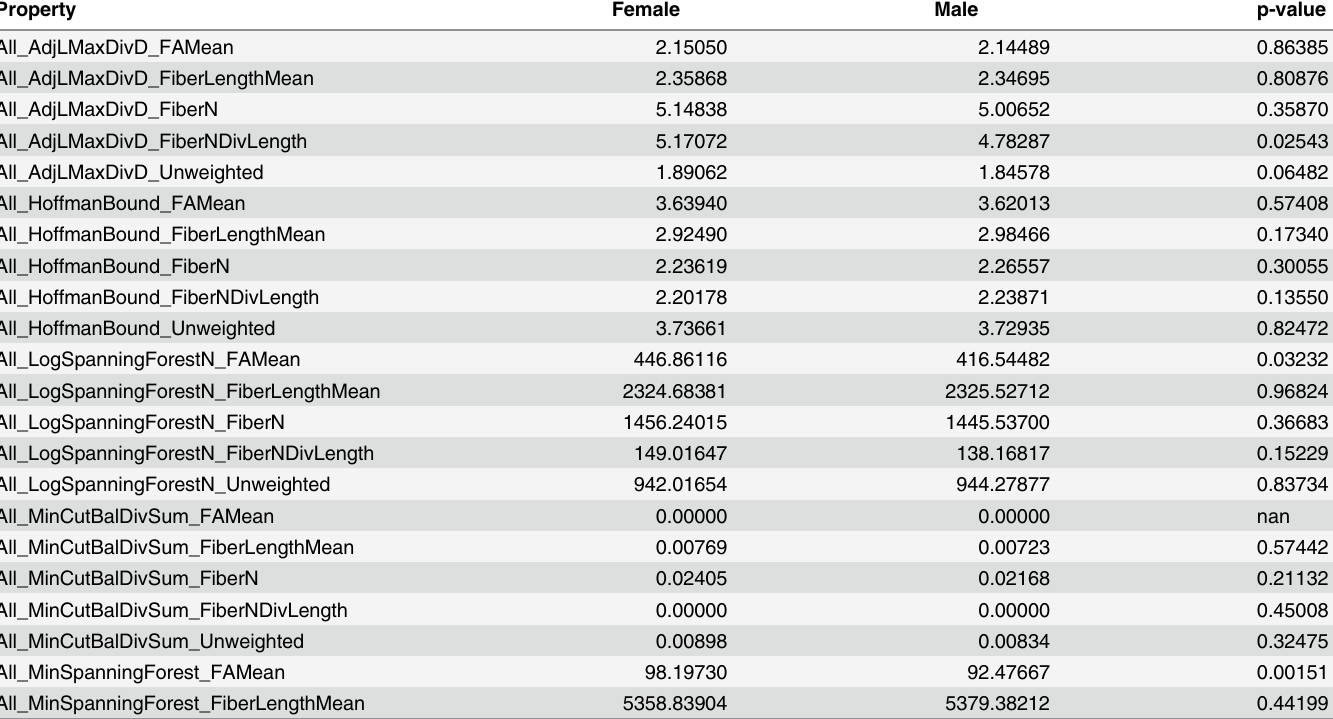
Table 5. The graph-theoretic parameters computed for the 463-vertex graphs. The table contains their arithmetic means in the male and female groups, and the corresponding p-values in round 1 (see the “ Statistical analysis ” subsection). The results of the graph-parameters are defined in the caption of Table 1. Significant differences ( p < 0.01) are denoted with an asterisk in the last column.